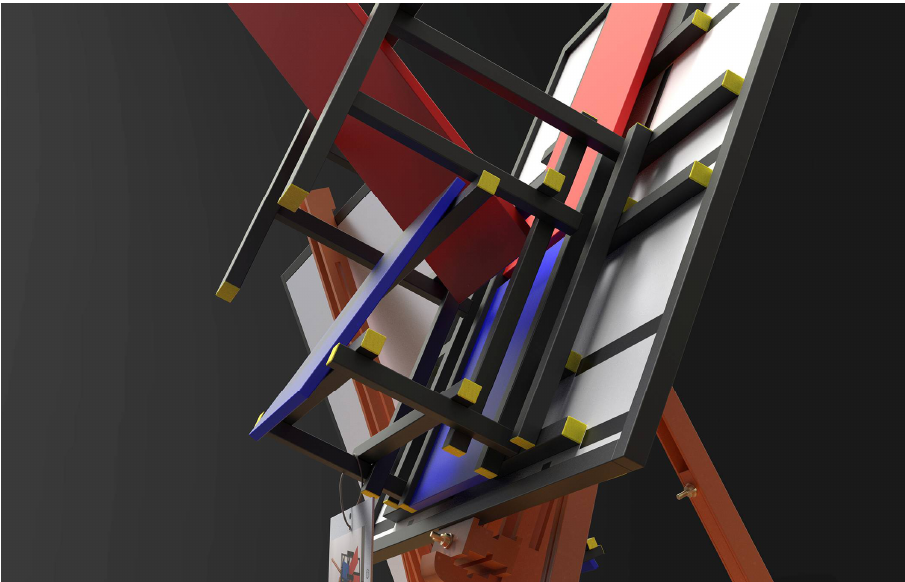
Figure 4. Gabriele di Virgilio, Ciro de Candia: “ The Mongian iconic dihedral